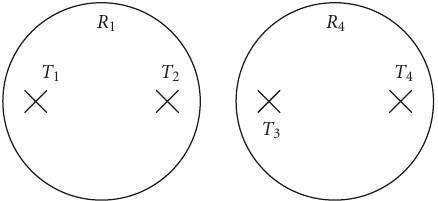
Figure 6: The reduced RFID network after performing RRE + LEO and LEO + RRE